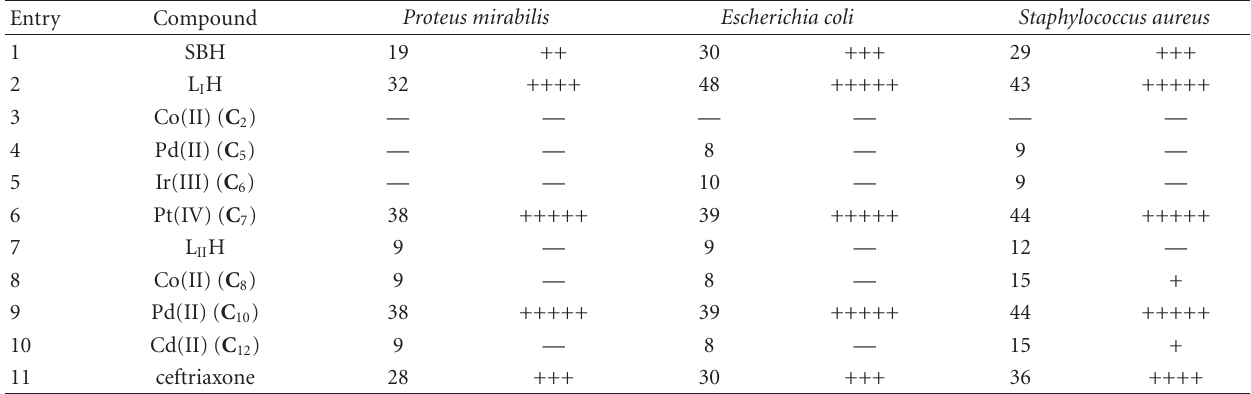
Table 5: Antibacterial activities of the Schi ff and Mannich bases and some selected metal complexes showing inhibition zones in diameters